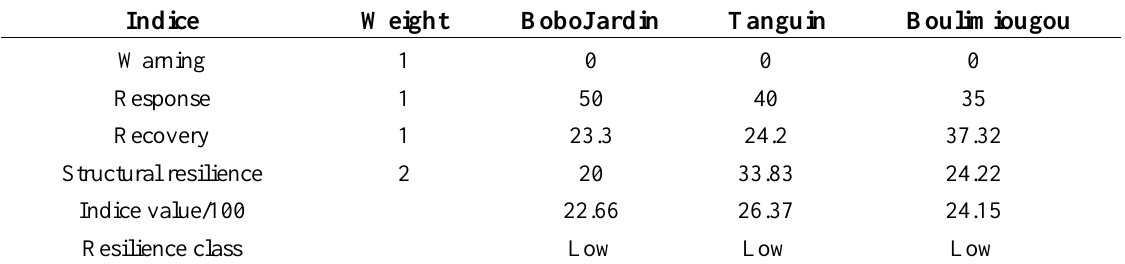
Table 4. AgWater resilience level to climate risks and change to three agricultural sites in Burkina Faso (detailed results).